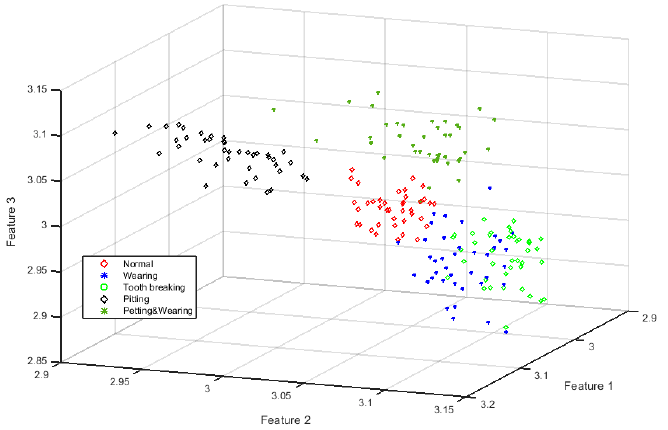
Figure 17. Three dimensions of the IMAAPE feature vectors for different fault types of the gearbox.